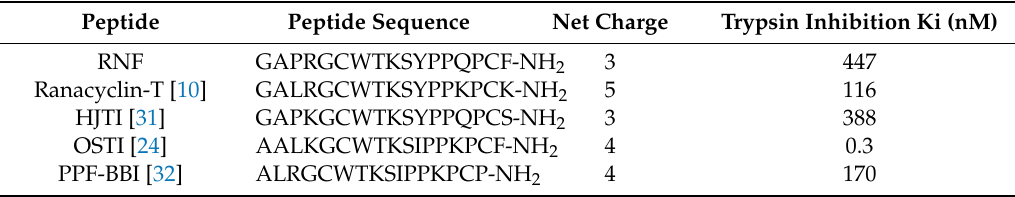
Table 3. Some parameters of RNF and some reported ranacyclins and their trypsin inhibition Ki values. Amino acid residues at P5 (cid:48) are